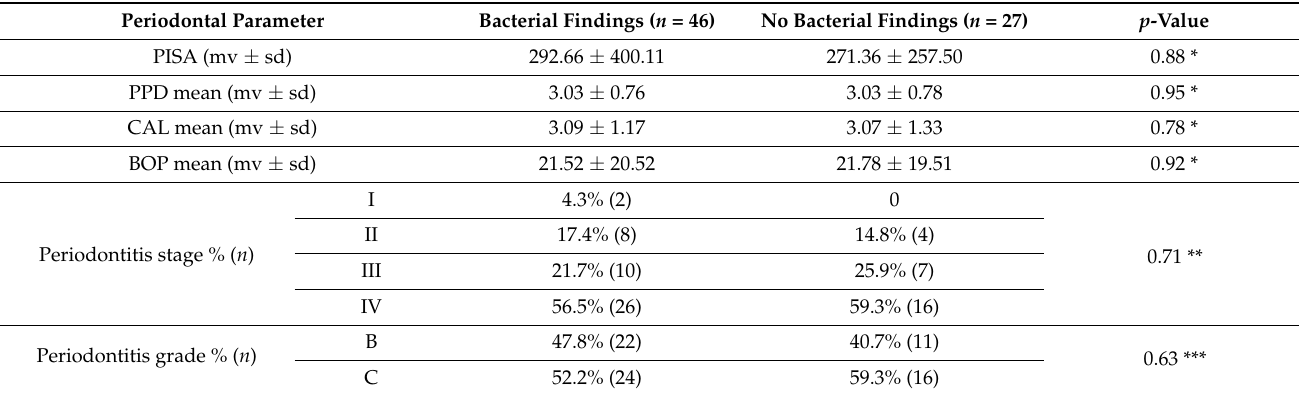
Table 6. Association between bacterial findings 12 months prior to/after oral examination and periodontal health